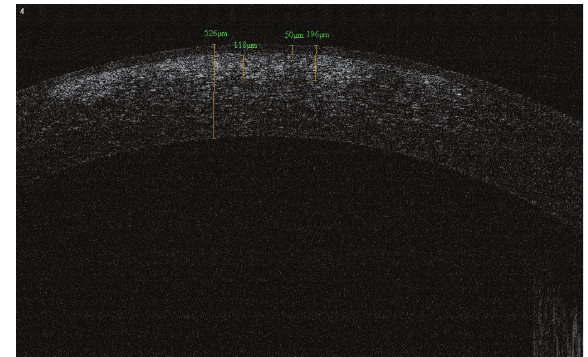
Figure 2: A patient with permanent opacities in the visual axis due to an episode of Adenoviral conjunctivitis. Note the presence of deep opacities (196 µ m with corneal epithelium).